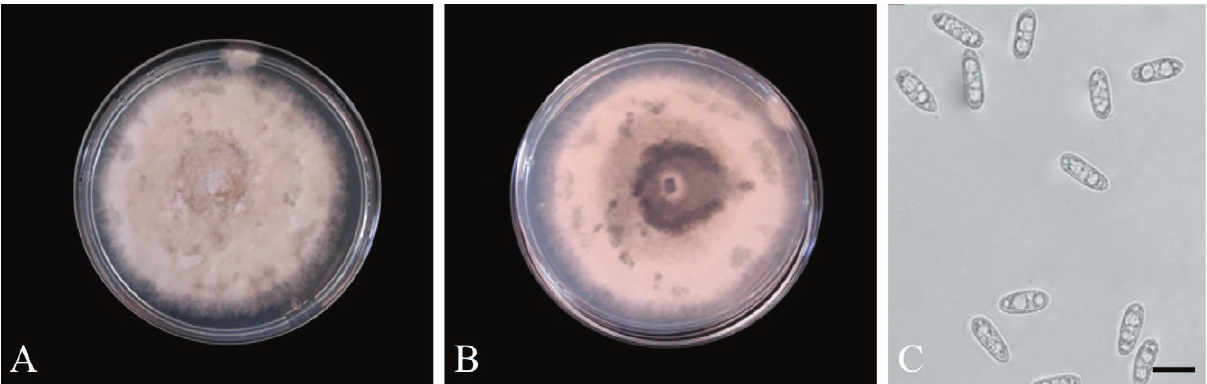
Figure 3. Front (A) and reverse (B) sides of a Colletotrichum helleniense colony (CVG629 strain) grown for 7 d on PDA, and conidia (C). Scale bar = 10 μm.